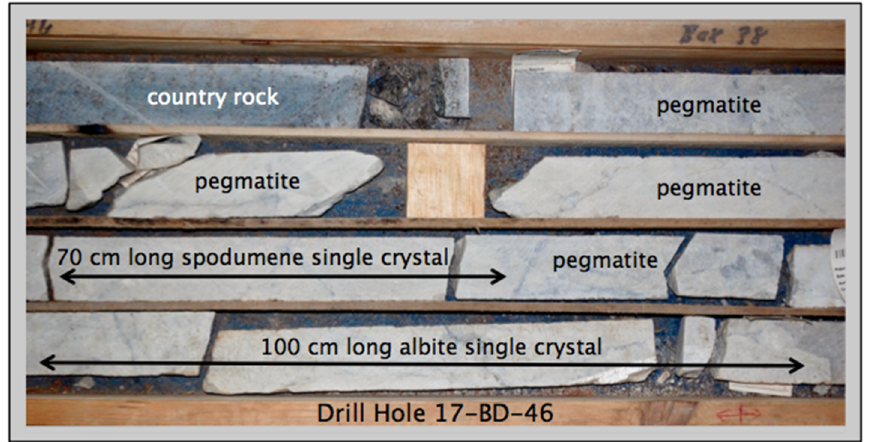
Figure 3. Carolina Lithium Project drill core 17-BD-46 between 107.51–110.21 m depth showing from top to bottom metamorphic country rock, and typical pegmatite containing a 70-cm-long crystal of spodumene and a 1-m-long albite crystal.